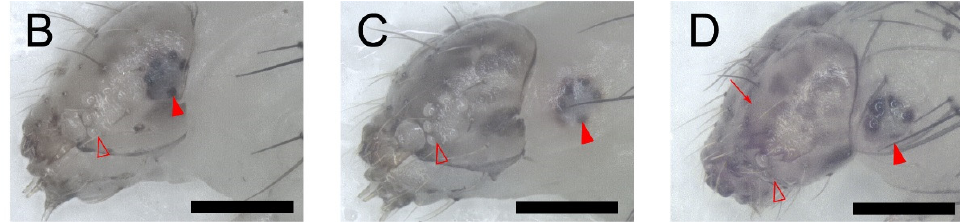
Figure 2. The larval–larval ecdysis of P. xylostella larva. The full red arrowheads point to the stemmata, and the hollow red ones point to the hollow stemmata on the old head capsule. The arrow points to the pigmented mandibles. Scale bar = 300 μ m. n = 33 in L1–L2 ecdysis, n = 38 in L2–L3 ecdysis, and n = 53 in L3–L4 ecdysis. ( A ) Stage I: No significant change in its stemmata. ( B ) Stage II: Head capsule slip. Six stemmata on the old head capsule turned white and six “black spots” (stem- mata pigment spots on the new head capsule) moved posteriorly, which means the head capsule moved anteriorly to the larva. ( C ) Stage III: Relative quiescence. All stemmata on the new head capsule have already emerged from the posterior side of the old head capsule in this stage. ( D ) Stage IV: Pigmentation of new mandibles.